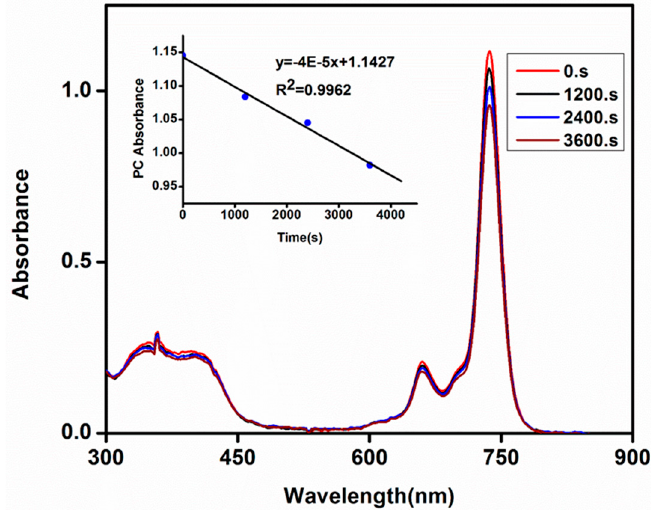
Figure 3. UV-Vis absorption spectral changes during the determination of photodegradation quantum yield for phthalocyanine 3b in DMSO showing the disappearance of the Q band at 20 minutes intervals. Inset: the plots of the phthalocyanine (Pc) absorbance versus time.